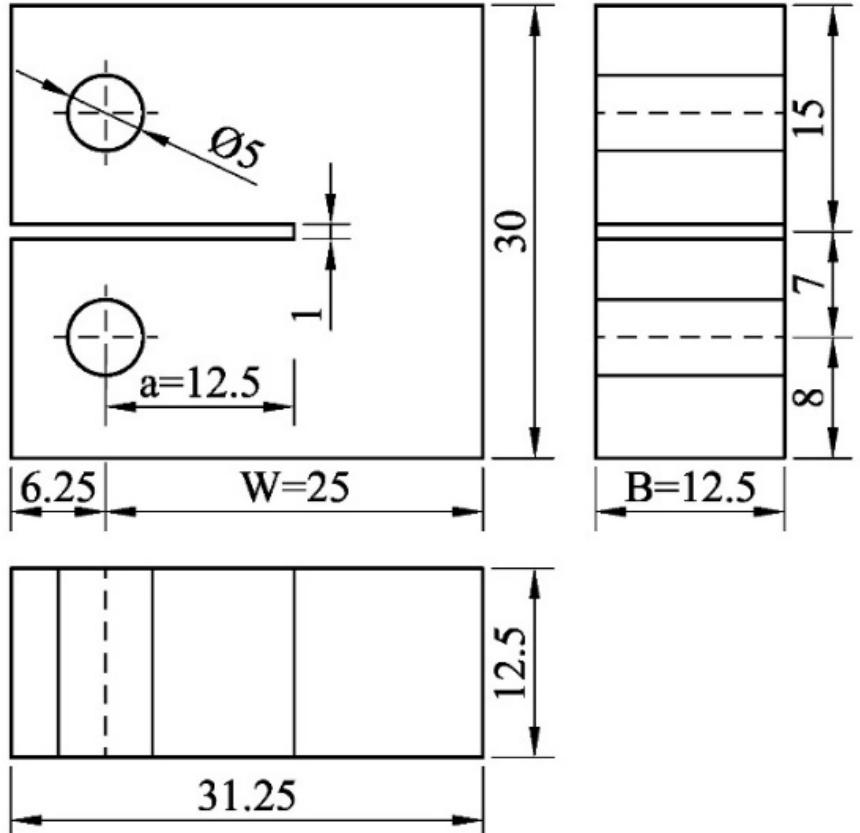
Figure 2. Dimensions of compact tension sample evaluated in this study.